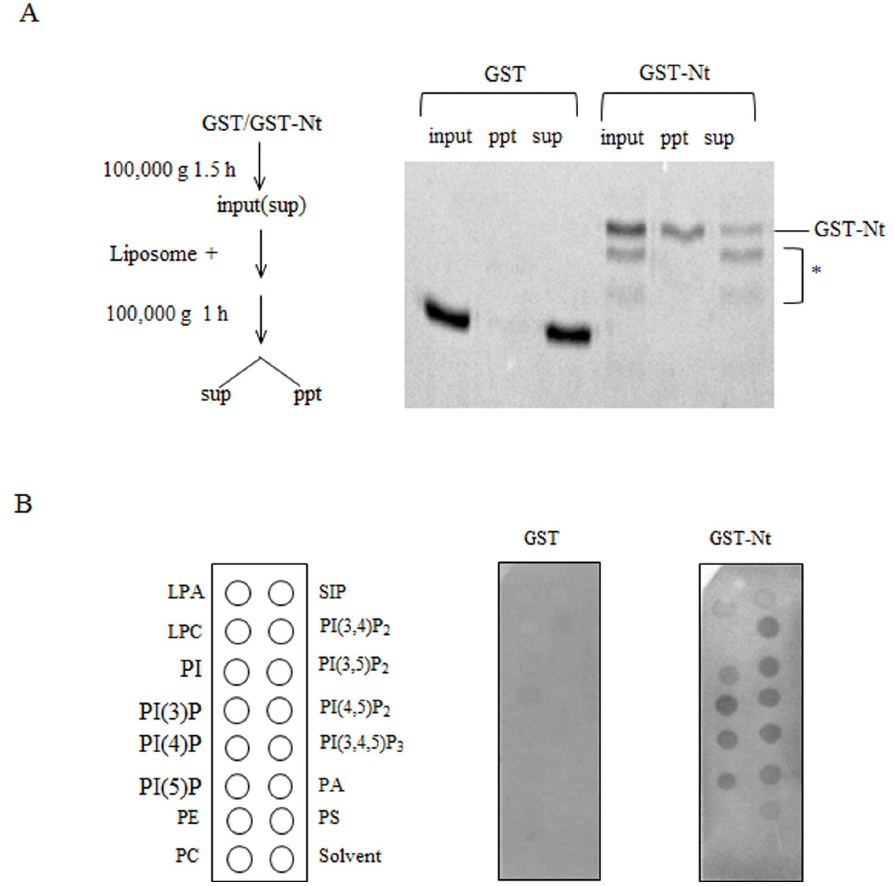
Figure 4. The interaction between the Nt and lipid bilayers. (A) Liposome co-sedimentation assay. Nt was produced as a fusion protein with glutathione transferase (GST-Nt) in the BL21 strain of Escherichia coli and purified with glutathione-Sepharose 4B beads. GST was used as a control. Diagram showing the liposome sedimentation assay. GST and and GST-Nt were centrifuged before use to sediment insoluble proteins and mixed with liposomes (input). After centrifugation, the liposome-bound (ppt) and liposome-unbound (sup) fractions were recovered. Aliquots of each fraction were separated on an SDS-PAGE and stained with Coomassie brilliant blue. (B) Lipid binding assay using the spot array method. Lipid-spotted membrane strips were incubated with GST or GST-Nt and the lipid-bound proteins were detected using anti-GST antibody. LPA, lysophosphatidic acid; PI, phosphatidylinositol; PI(3)P, phosphatidylinositol-(3)-phosphate; PI(4)P, phosphatidylinositol-(4)-phosphate; PI(5), phosphatidylinositol-(5)- phosphate; PE, phosphatidylethanolamine, PC, phosphatidylcholine; SIP, sphingosine-1-phosphate; PI(3,4)P 2 ; phosphatidylinositol-(3,4)-bisphosphate; PI(3,5)P 2 , phosphatidylinositol-(3,5)-bisphosphate; PI(3,4,5)P 3 , phosphatidylinositol-(3,4,5)-trisphosphate; PA, phosphatidic acid; PS, phosphatidylser-